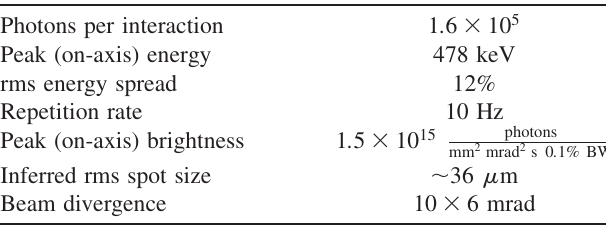
TABLE III. Gamma source performance